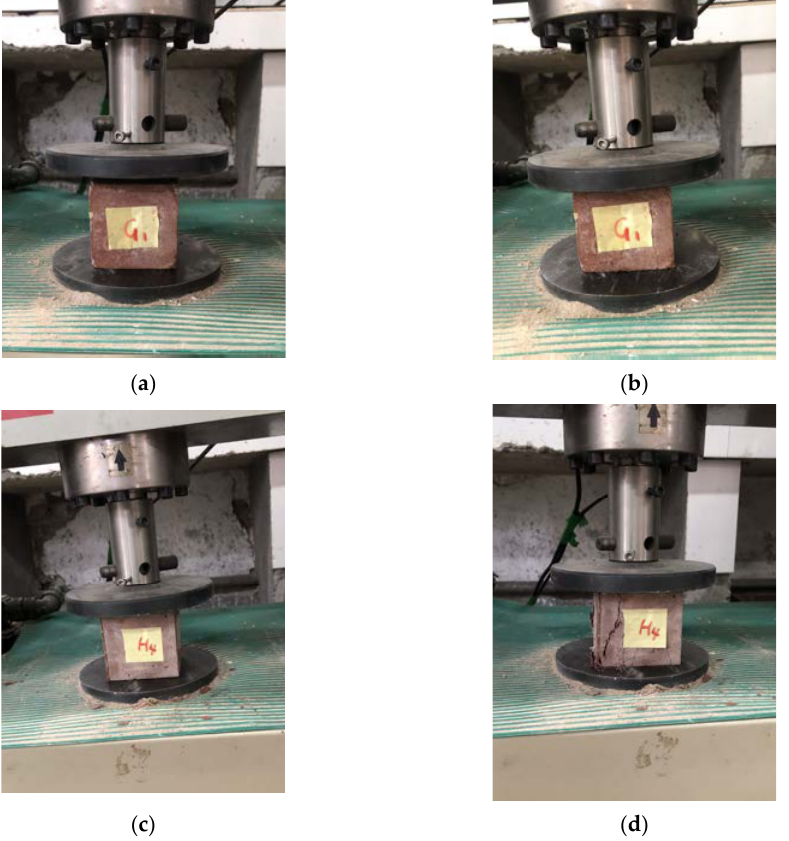
Figure 5. Unconfined compressive strength test of NUC-FM. ( a ) Compressive strength test of Group G test block; ( b ) Group G test block destruction; ( c ) Compressive strength test of Group H test block; ( d ) Group H test block destruction.